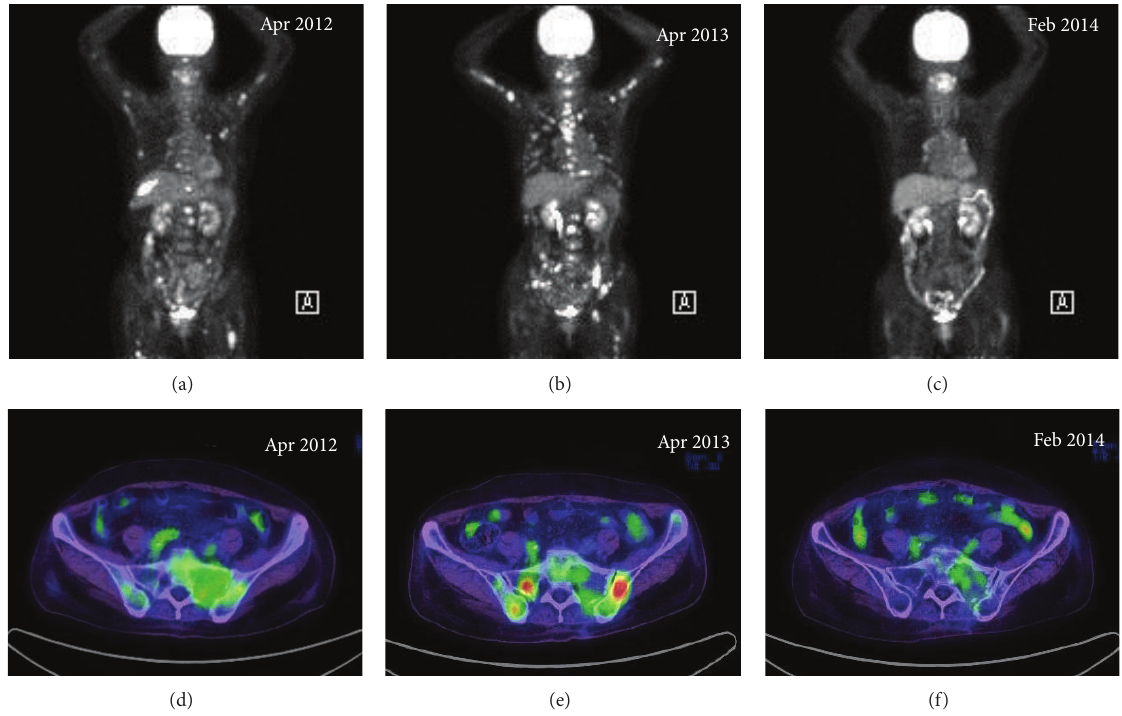
Figure2:Coronalandaxialfused 18 F-FDGPET/CTimages.(a)Initialdiagnosisofmyeloma,multiplefociofmetabolicactivity.(b)Extension oflesionsandnewlesionsfollowingrelapse.(c)Completemetabolicresolutionofmyeloma.(d)Ininitialdiagnosisofmyeloma,PET/CTimage shows 18 F-FDG avid lytic lesions sacrum and iliac bone involvement. (e) In relapsed myeloma, PET/CT image shows developed 18 F-FDG avid iliac and sacral bone lesions. (f) After 10 months undergoing LEN/DEX therapy, PET/CT image shows complete resolution of the metabolic